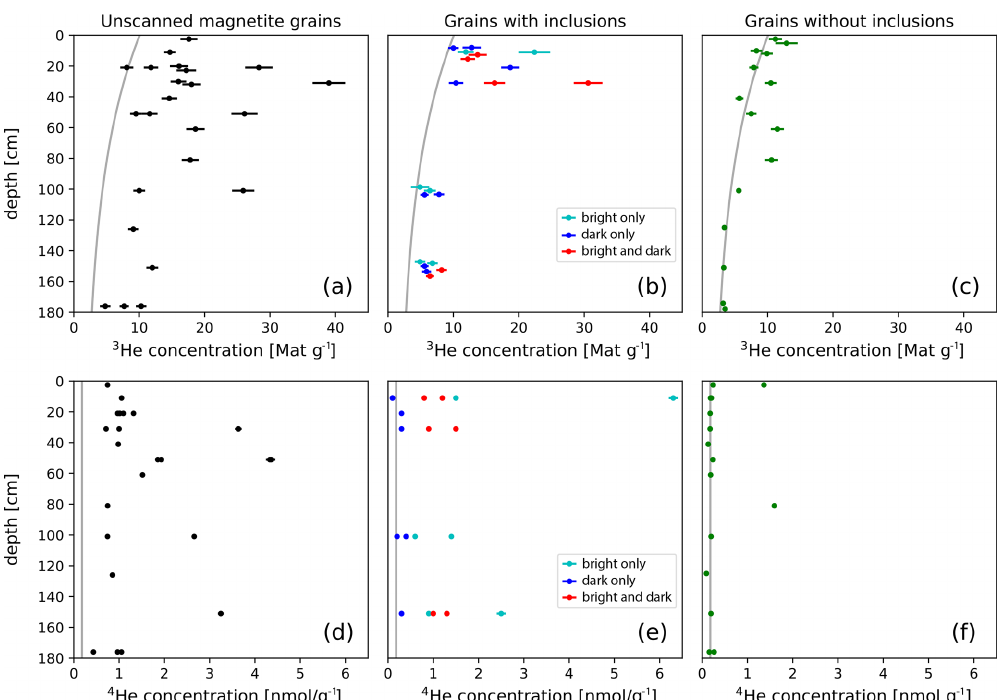
Figure 9. Depth profiles of measured 3 He (a–c) and 4 He (d–f) concentrations from unscanned magnetite grains without information about inclusions (black); samples with bright (turquoise), dark (blue), and bright and dark inclusions (red); and samples without inclusions (green). All uncertainties shown are at the 1 σ level, and overlapping data points have been slightly vertically offset for clarity. The expected cosmo- genic 3 He depth profile based on the known exposure age and the average 4 He concentration of aliquots without inclusions are shown as gray lines. Samples without inclusions have 3 He concentrations close to the predicted depth profile and all but two have low, nearly constant 4 He concentrations (around 0.18nmolg − 1 ). Grains with inclusions have significantly higher 3 He and 4 He concentrations, showing the effects of fissiogenic and thermal-neutron-produced 3 He added by these inclusions. The 3 He concentration decreases with depth even in grains with inclusions, indicating a cosmogenic thermal neutron component to nucleogenic